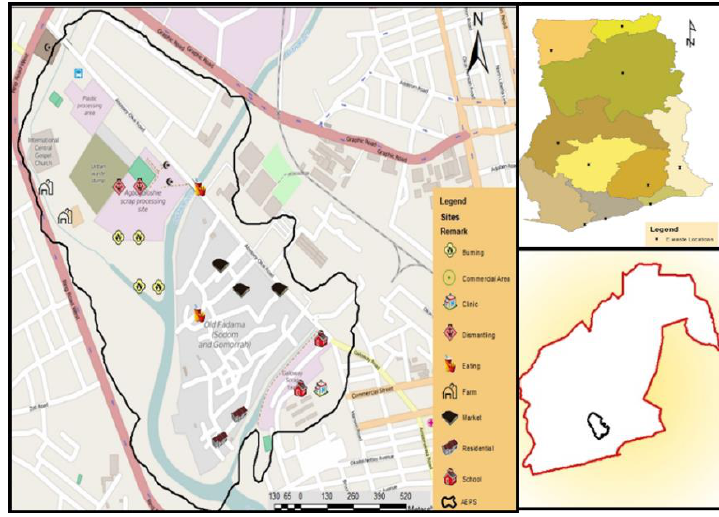
Figure 1. Location map of Agbogbloshie e-waste processing